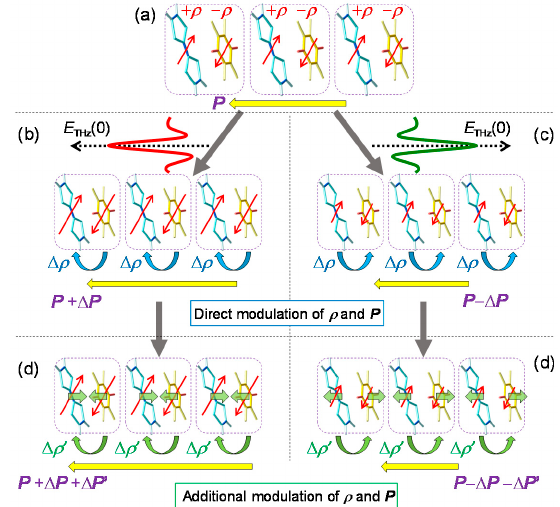
Figure 23. Schematics of observed responses to a terahertz electric-field pulse in the ionic phase of TTF-CA [41]. ( a ) Ionic phase with ferroelectric polarization P ; ( b , c ) Direct modulation of charge transfers and polarization by a terahertz electric field with E THz (0) directed to the left ( b ) and right ( c ), respectively. Amplitude of ferroelectric polarization increases in the case of ( b ) and decreases in ( c ); ( d , e ) Additional modulation of charge transfer and polarization via dimeric molecular oscillations; ( d ) increases and ( e ) decreases dimeric molecular displacements, charge transfers, and polarization. Straight green arrows represent dimeric molecular displacements; Curved arrows in ( b – d ) indicate induced charge transfers.